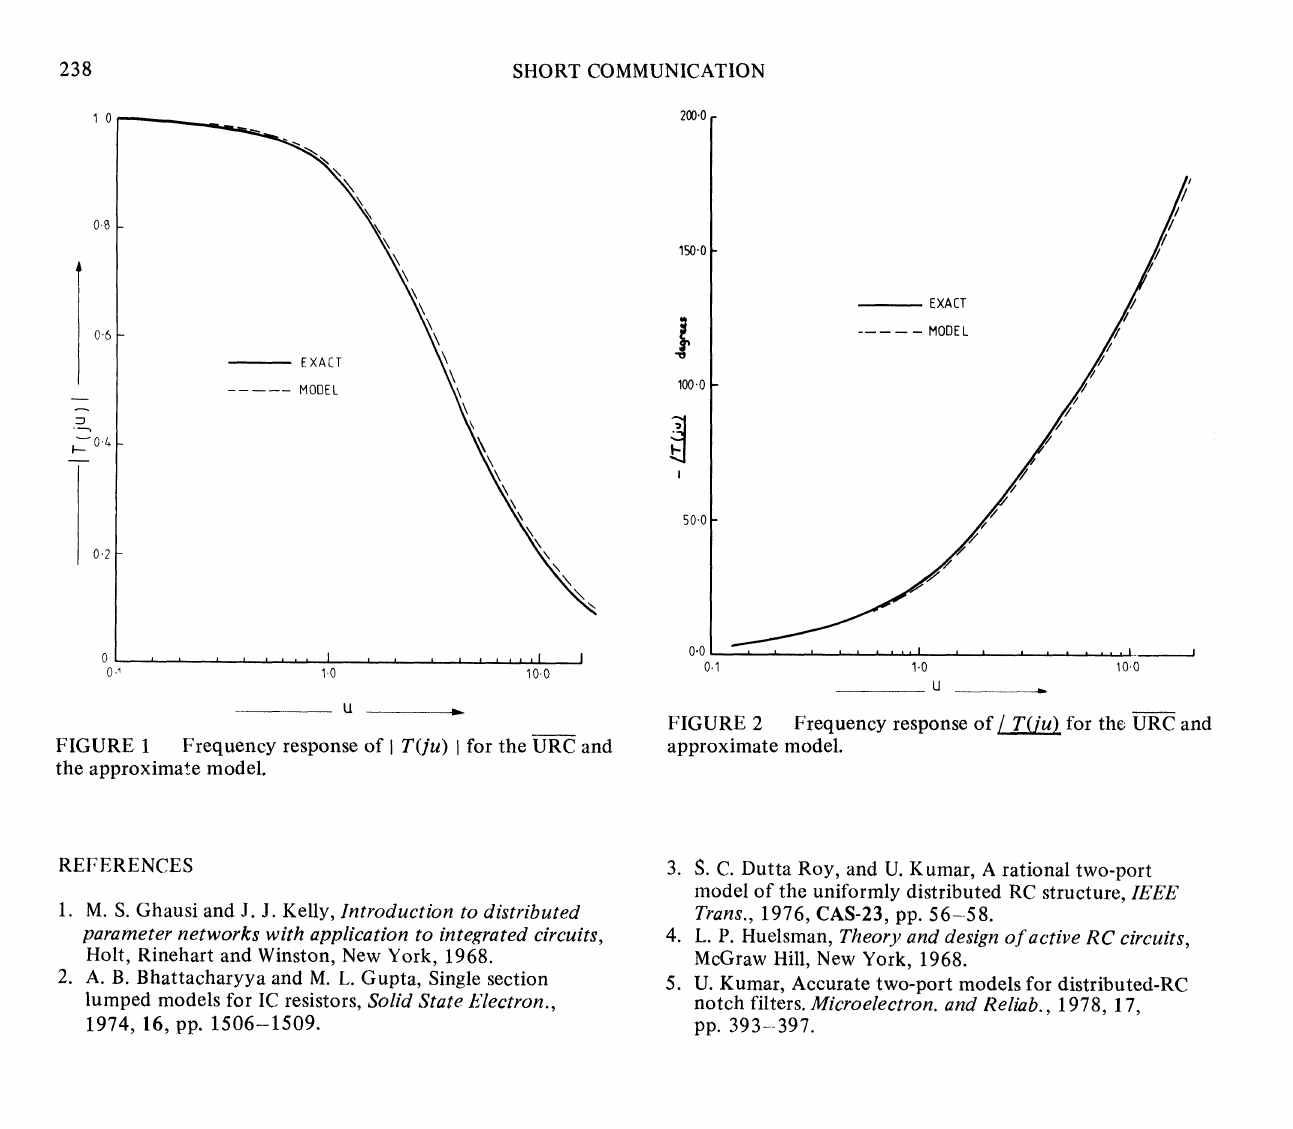
FIGURE Frequency response of T(lu) for the URC and the approximate model.